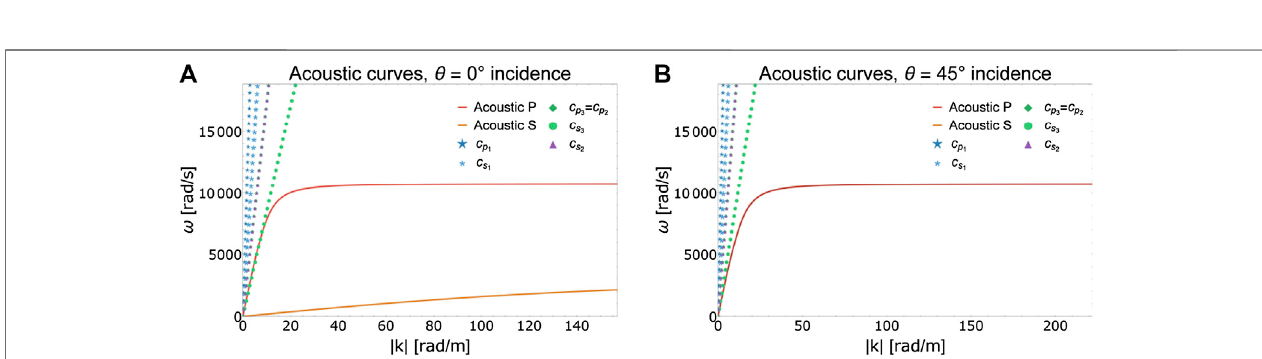
FIGURE6| Acousticcurvesofthemetamaterial MM1 (continuouslines)ascomparedtothedispersioncurvesofthreedifferentCauchymaterials(dottedlines).Itis highlighted that two dispersion curves coincide since c p numerical values of these speeds).